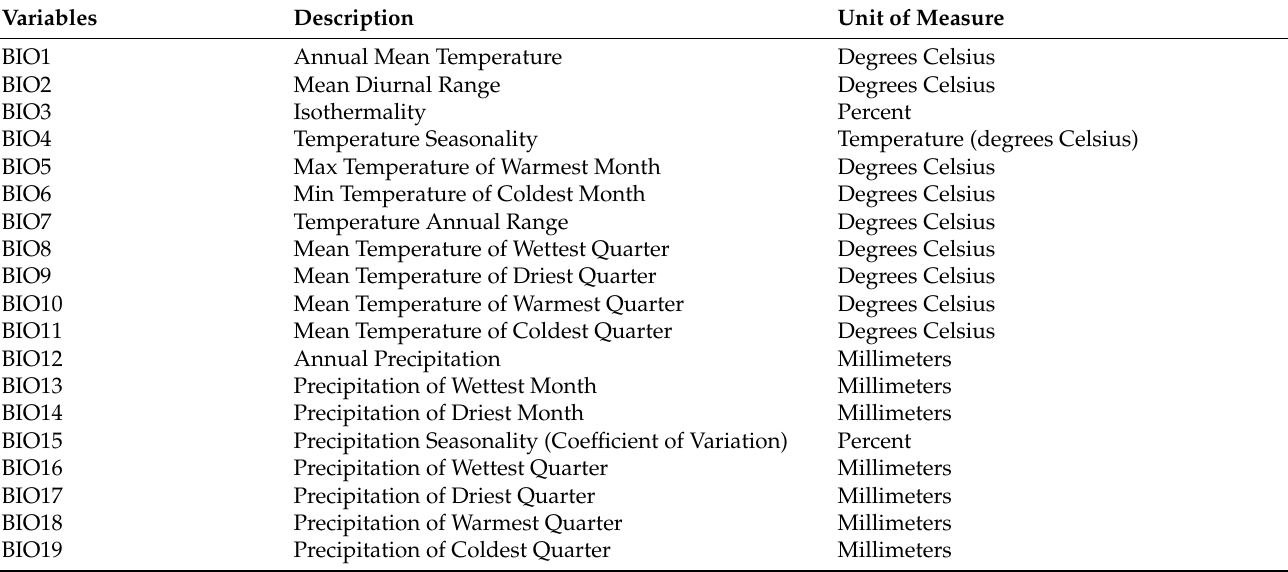
Table 1. Explanation of the WorldClim bioclimatic variables.